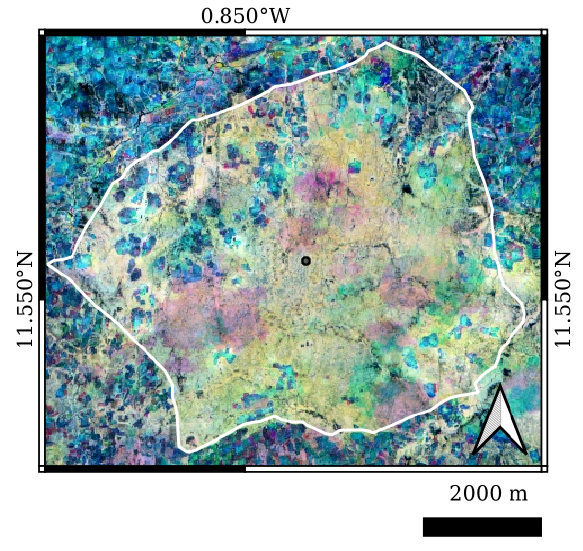
Figure 6: 3PTS image of the Niassa Pastoral Zone from 2017, with the zone’s borders in white. EPSG 4326 permanent structures in the reserves (habitations, wells or park buildings).